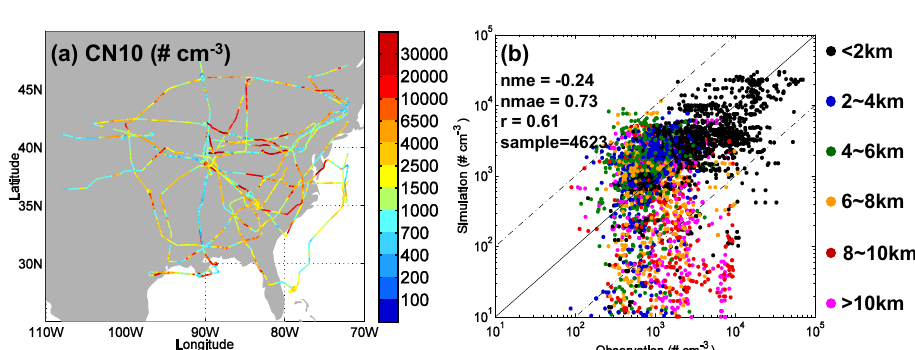
Fig. 3. Same as Fig. 2, except for sulfate.